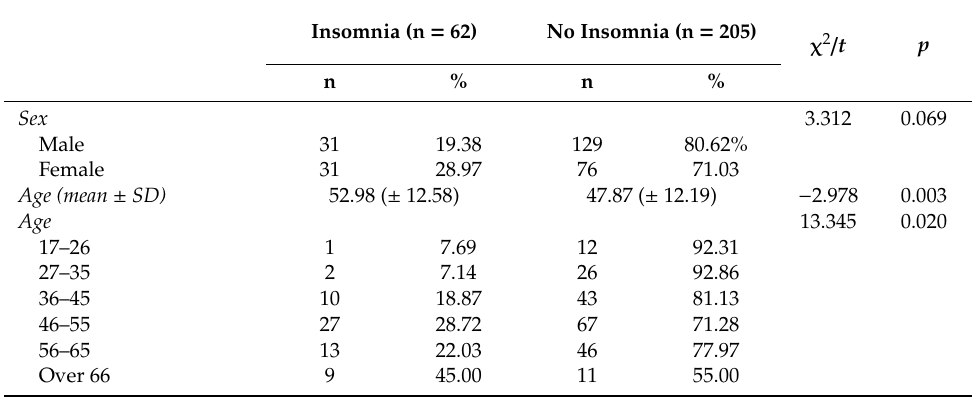
Table 1. Sociodemographic and clinical variables according to presence / absence of